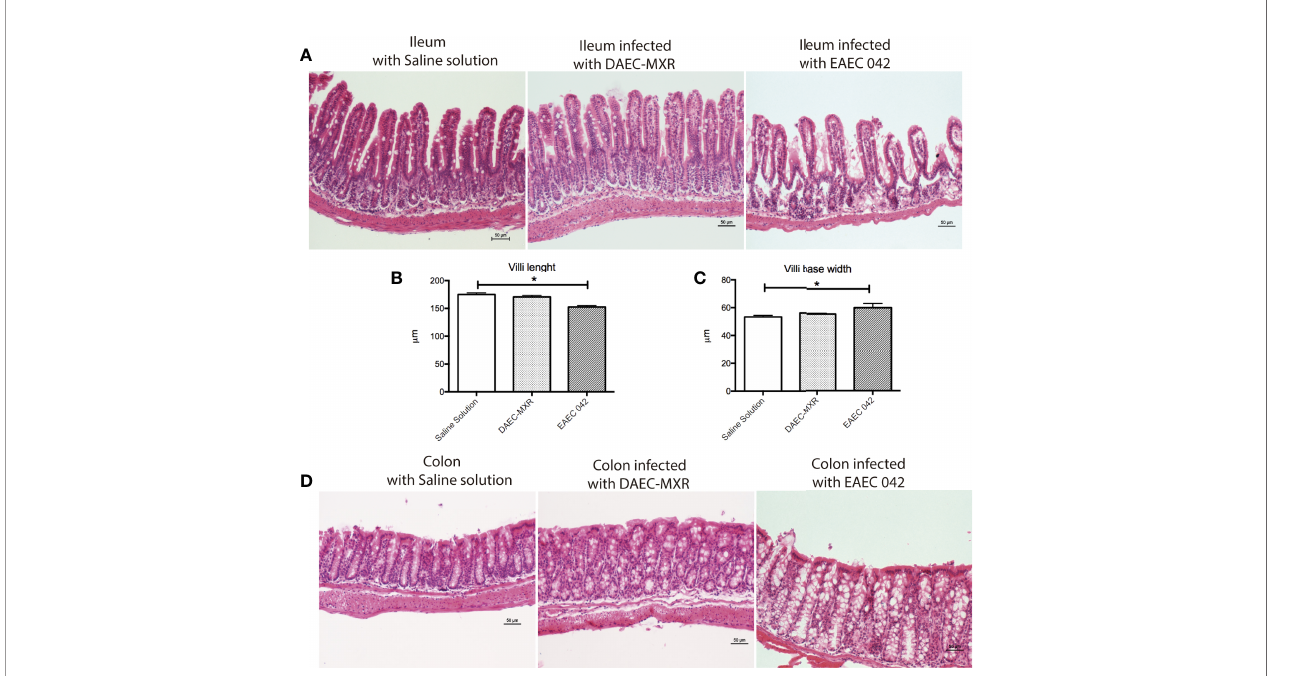
FIGURE 2 | Histopathology of gut infection with EAEC 042 and DAEC-MXR. (A) Ileum stained with H&E. Ileum from mice infected with EAEC 042 at day 7 post- infection presented edema zones and shorter and wider villi than control mice and DAEC-MXR. (B) Villus length. EAEC 042-infected mouse ileum had signi fi cantly shorter villus than saline solution control and DAEC-MXR mice, * p < 0.05. Ileum villus length was measured from tissue section (N = 5 mice per group. (C) Villi width. EAEC 042- infected mice had signi fi cantly wider villi bases in comparison with control mice and DAEC-MXR-infected mice. (D) Colon stained with H&E. An increased mucus secretion and cell shedding were observed in the colon of EAEC 042-infected mice in comparison with control mice. EAEC, enteroaggregative Escherichia coli